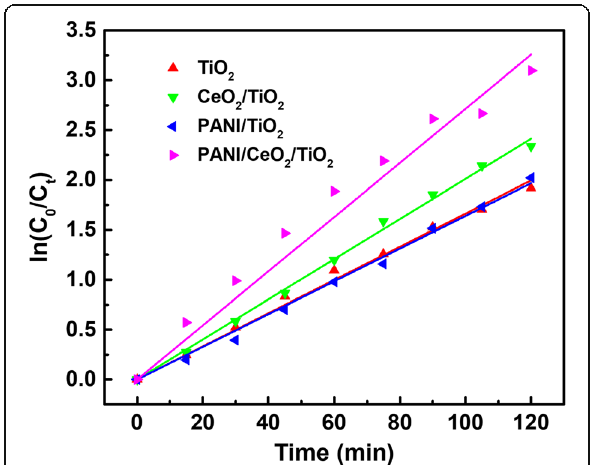
Fig. 2 Photoelectrocatalytic degradation of TBBPA solution over the pure TiO 2 NTAs, CeO 2 /TiO 2 NTAs, PANI/TiO 2 NTAs, and PANI/CeO 2 / TiO 2 NTAs. The geometric surface area of TiO 2 electrode was 2.0 × 2.5 cm 2 . Initial concentration of TBBPA: 10 mg L − 1 , volume: 50 mL,